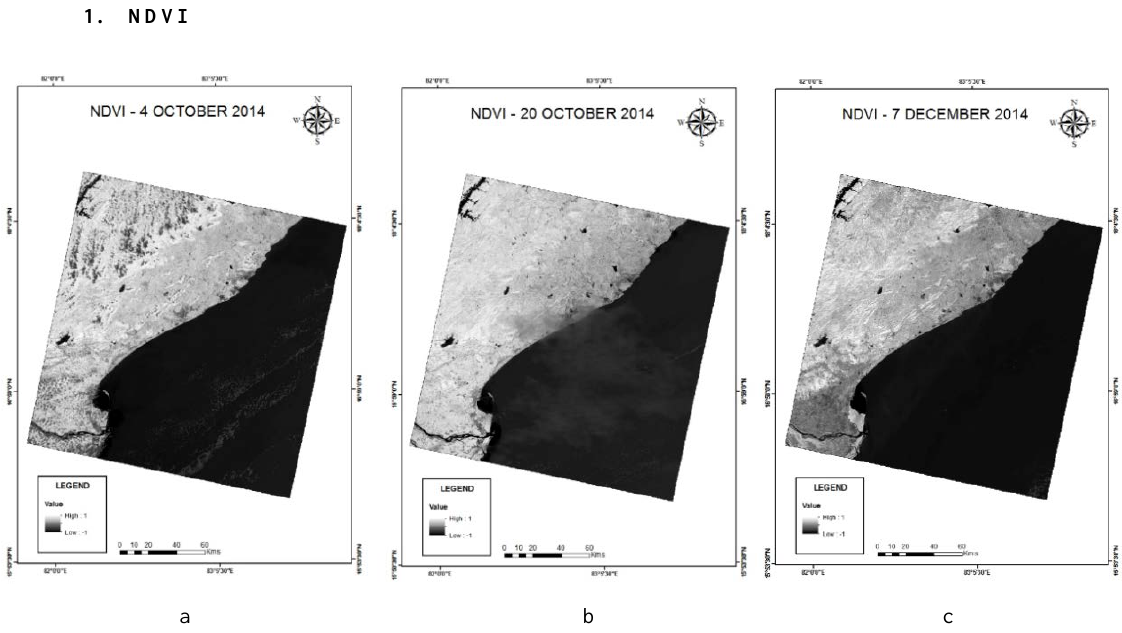
Figure 5. (a) NDVI from base map 4 Oct 14 (b) NDVI from base map 20 Oct 14 (c) NDVI from base map 7 Dec 14